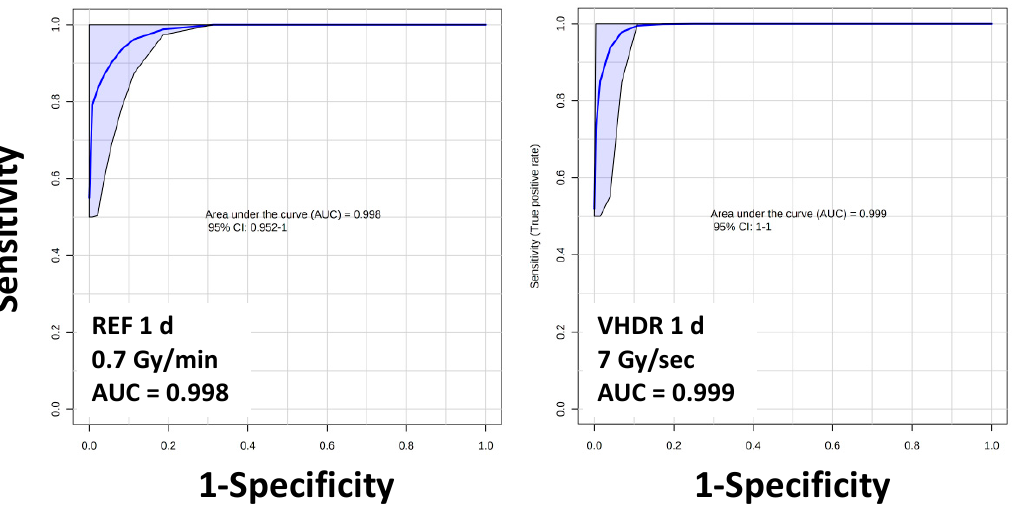
Figure 4. Area under the receiver operating characteristic curves (AUROC) values for serum lipids show excellent sensitivity and specificity (AUROC > 0.9) irrespective of dose rate. Lipid